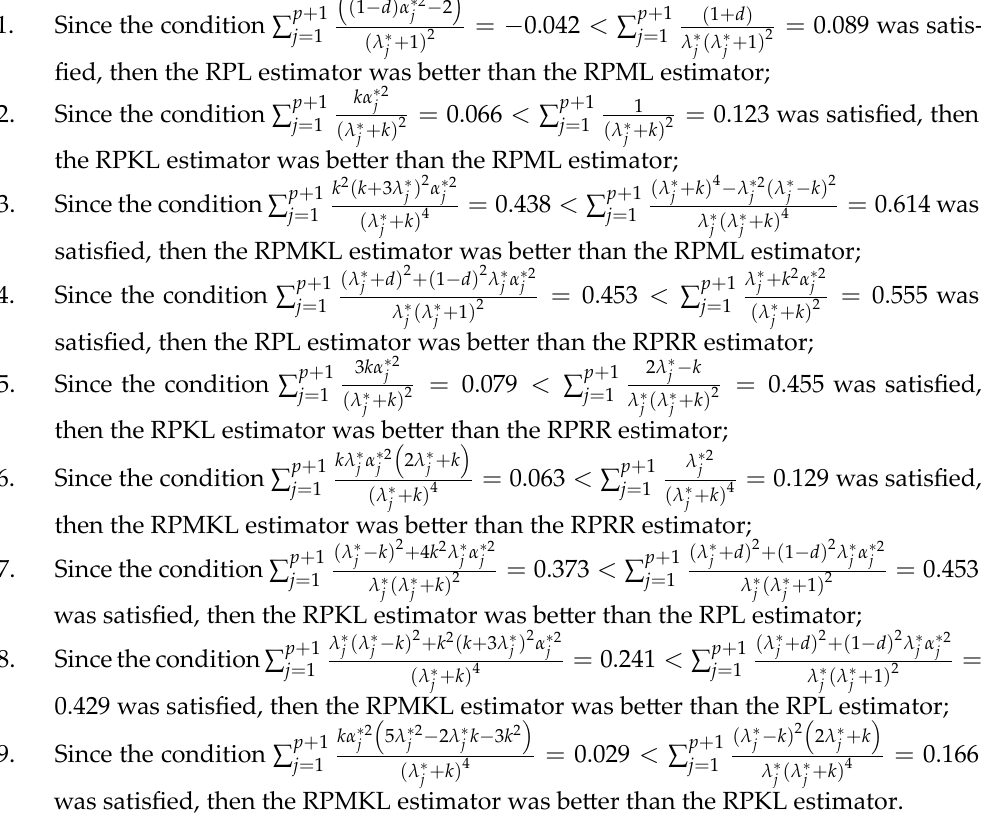
Figure 6. MSE values of the robust estimators against k and d of the Somerville Lake data. 5. Conclusions In the PRM model, the problem of outliers causes the PML to be inefficient. In this case, the RPML is considered to reduce the effects of the outlier values. Additionally, the PML performed the worst in the case of the existence of the multicollinearity problem. Therefore, some proposed biased regression estimators in the PRM model were consid- ered to handle multicollinearity, such as the PRR, PL, PKL, and PMKL (Månsson and